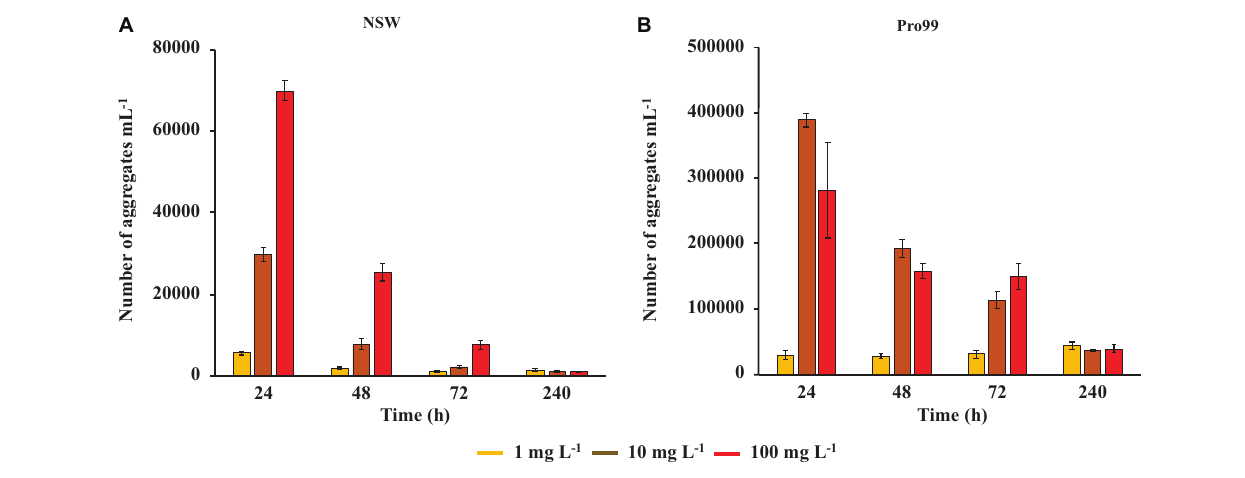
FIGURE 4 | Estimated number of cyanobacterial-nCeO 2 aggregates as monitored during flow cytometric analysis of Prochlorococcus sp. MED4 cultures grown in NSW (A) or Pro99 media (B) exposed to nCeO 2 in the mg L − 1 range (1–100 mg L − 1 ). Data represents the mean of three culture replicates ± standard error ( n = 3). No such aggregates were observed during analysis of cultures exposed to lower concentrations (i.e., 1–100 µ g L − 1